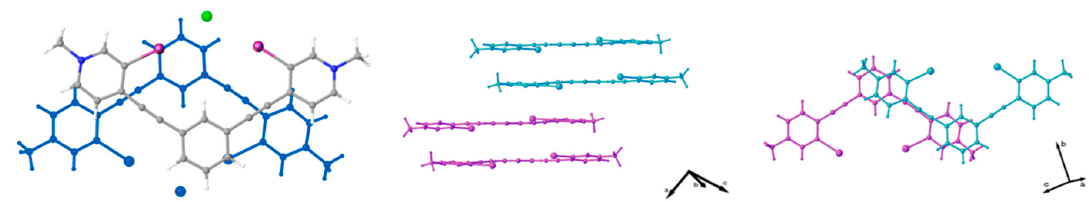
Figure 7. Ball-and-stick models highlighting the ‘slipped’ centered antiparallel dimer of the chloride structure ( left ) and arrangement of these slipped dimers to form off-centered antiparallel dimers ( center and right ).